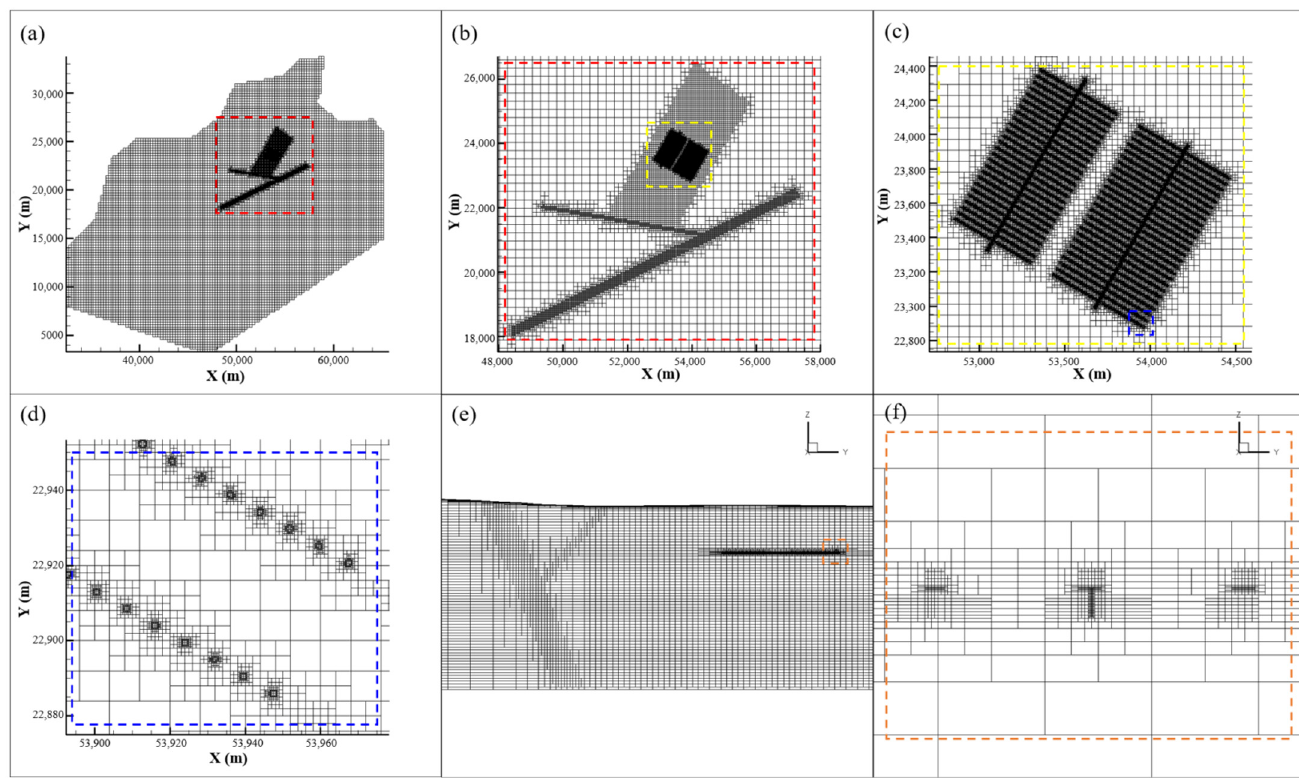
Figure 7. The computational grid in this study. ( a ) The horizontal plane view of the grids on the plane of z = − 504 m; ( b ) The zoom-in view of girds for F1, F2, and repository zones based on the selected local area (red dashed line) shown in ( a ); ( c ) The refined grids for the repository area based on the selected local area (yellow dashed line) defined in ( b ); ( d ) The further zoom-in view of the DTs and DHs on the plane of z = − 504 m. The local area is marked with the blue dashed line in ( c ); ( e ) The vertical profile of grids along x = 56,265; and ( f ) The close view of the refine grids for an MT and DTs in the area marked with the orange dashed line defined in ( e ).